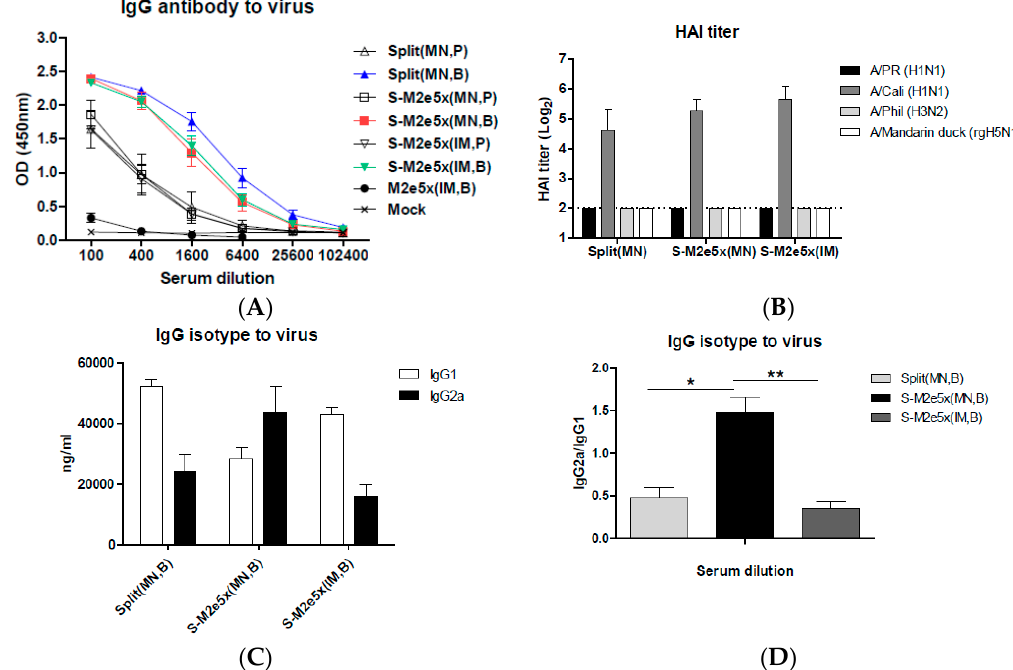
Figure 3. M2e5x VLPs co-immunized MN vaccination changed IgG isotype to viral antigens. BALB / c mice ( N = 12) were immunized with split vaccine alone (Split MN) or split vaccine supplemented with M2e5x VLPs (S-M2e5x MN). IM control groups ( N = 12) include S-M2e5x (IM) and M2e5x (IM). ( A ) IgG antibody responses to influenza A / Cal virus. Sera were collected 3 weeks after prime (P) and boost (B) vaccination. The IgG level was detected using influenza A viruses, A / California / 04 / 09 (A / Cal, H1N1) as an ELISA coating antigen. ( B ) Hemagglutinin inhibition titers of immune sera. Hemagglutinin inhibition (HAI) titers were analyzed with boost sera as a measure of functional antibody responses against A / California / 04 / 09 (H1N1), A / PR / 8 / 34 (H1N1), A / Philippines / 2 / 82 (H3N2), and A / Mandarin duck / PSC24-24 / 2010 (rgH5N1) influenza viruses. The dotted line denotes the limit of HAI detection. ( C ) Comparison of IgG isotype antibody responses to influenza A / Cali virus. ( D ) Ratio of IgG isotype antibody (IgG2a / IgG1). Error bars indicate mean ± SEM. For statistical analysis, one-way ANOVA and Tukey’s post-multiple comparison test were performed. *; p < 0.05, **; p < 0.001 between the indicated